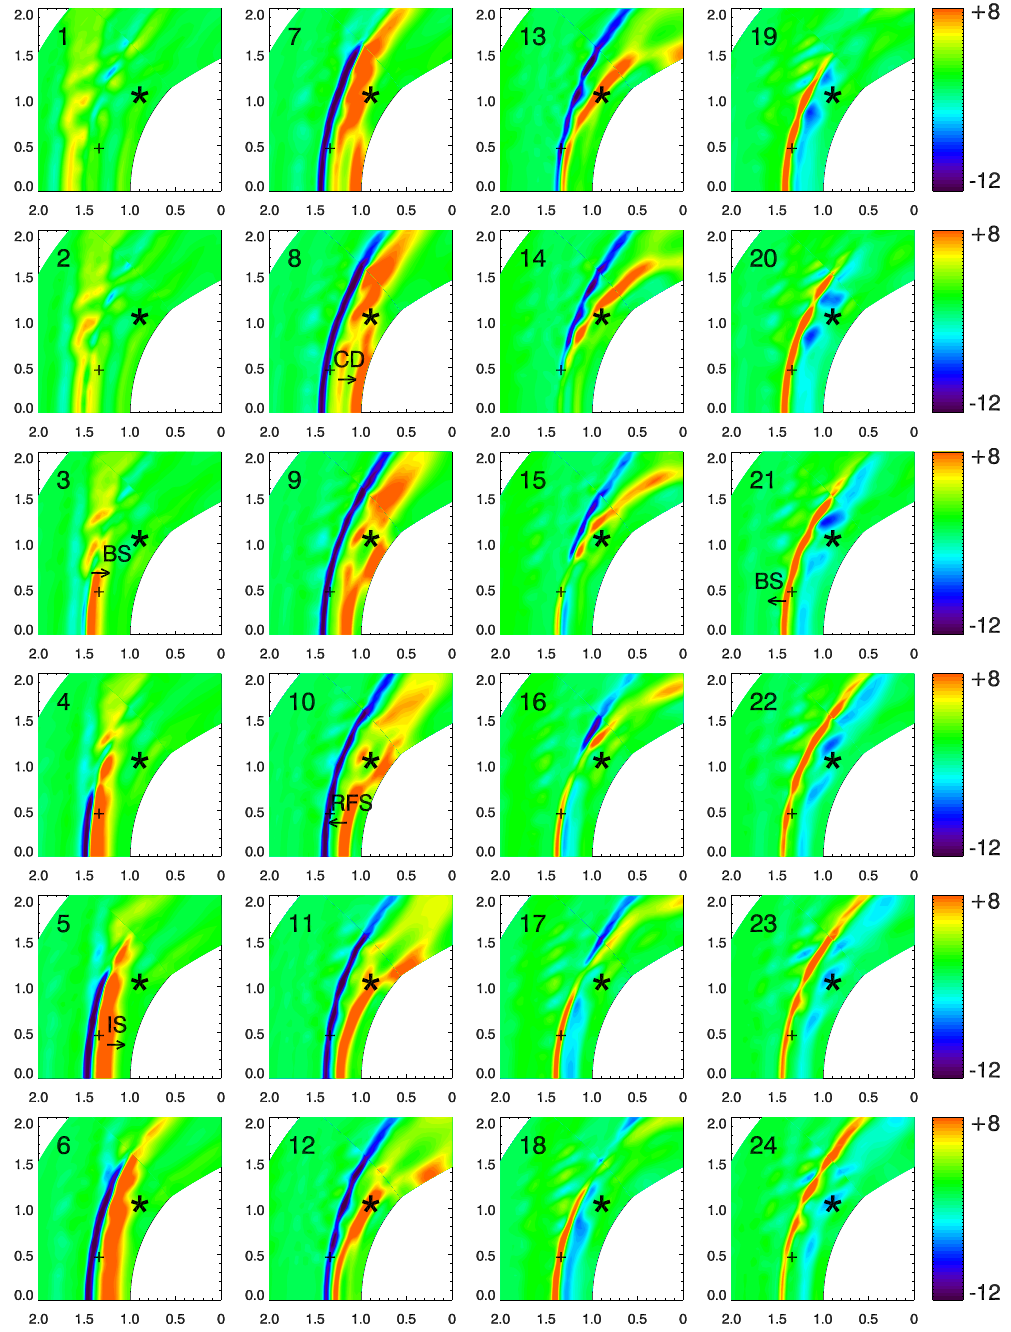
Fig. 8. Contours of 1n in the noon-meridional plane for a successive set of 24 time intervals, where 1n is a variation of density during 16s interval. The abbreviations BS, IS, CD, and RFS refer to the bow shock, interplanetary shock, compound discontinuity, and reflected fast shock, respectively. A star and a cross in every panel illustrate relative positions of simulated SC3 and TC1 with respect to the magnetopause and bow shock. The Sun-Earth line is along the horizontal